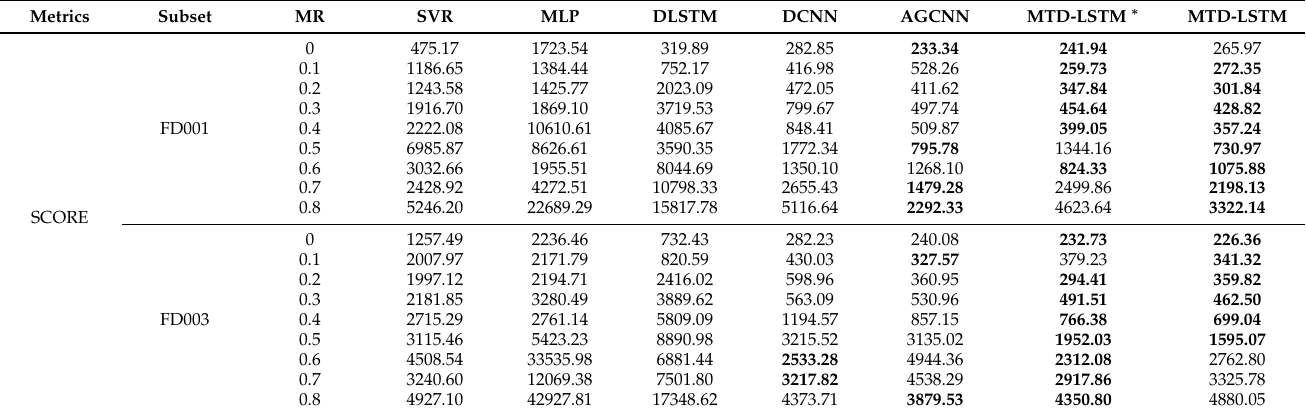
Table 6. RMSE and scores of compared methods on C-MAPSS under different missing rates